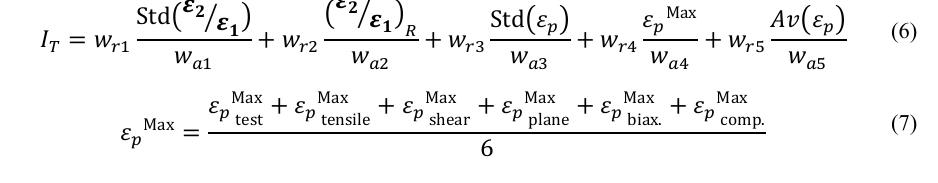
Table 2. Coefficients used to compute the heterogeneity indicator 𝑤 𝑟1 𝑤 𝑟2 𝑤 𝑟3